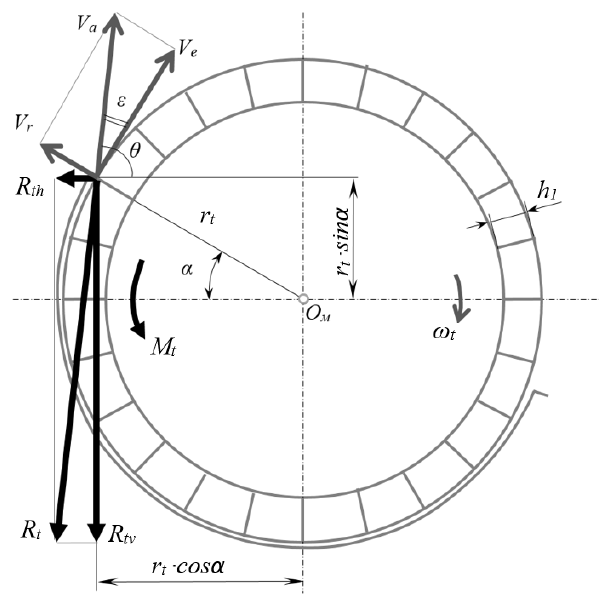
Figure 7. Calculation scheme for determining the loading of the soil